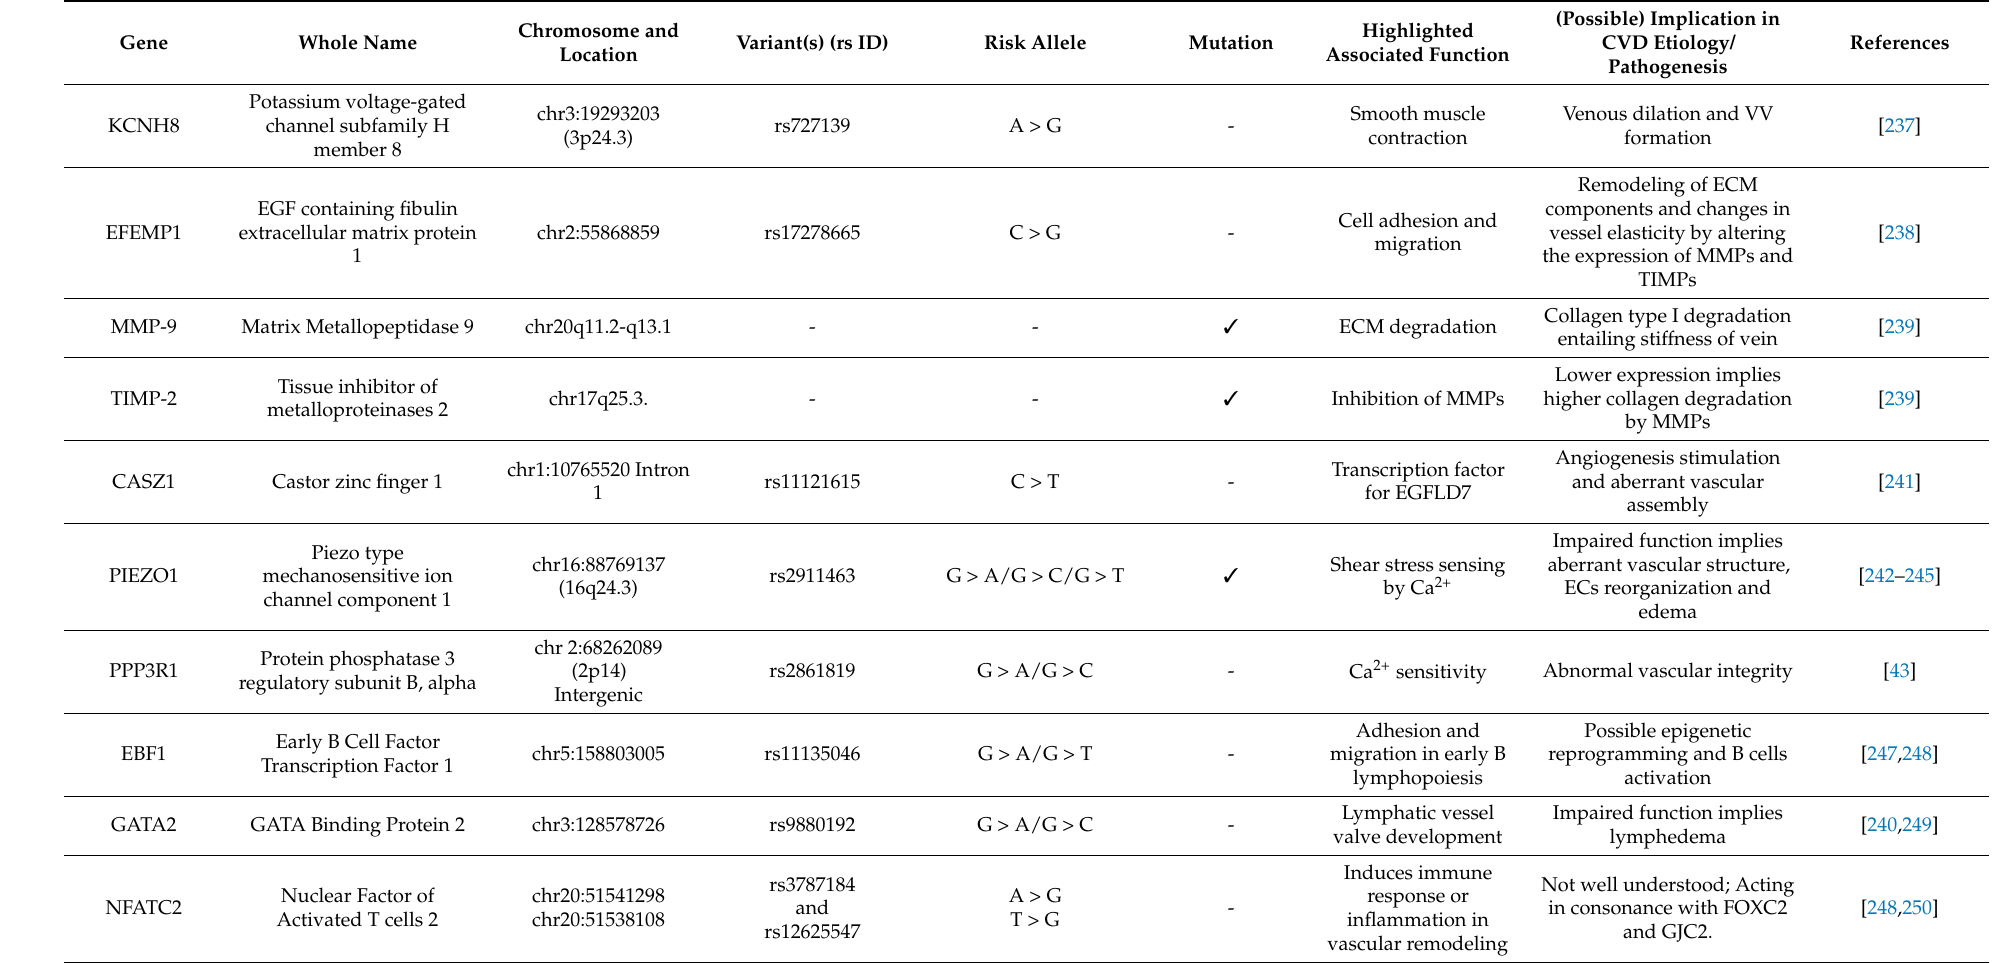
Table 2. Principal causal genes associated to CVD. ECM = Extracellular matrix, VV = Varicose